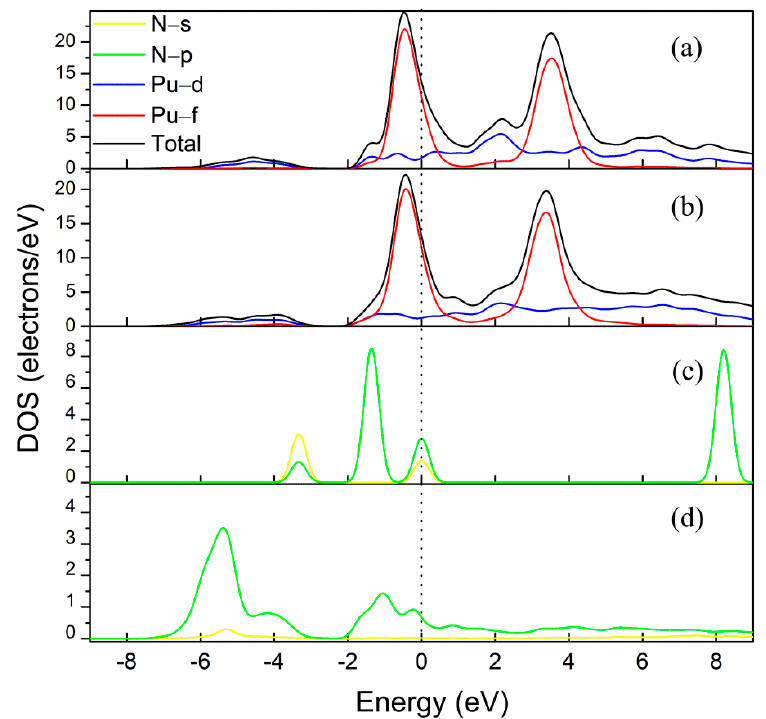
Figure 3. Partial density of states for ( a ) clean PuH 2 (111) surface; ( b ) PuH 2 (111) surface with adsorbed N 2 ; ( c ) gaseous N 2 , nitrogen; and ( d ) adsorbed N 2 . The smearing width was set to 0.2 eV and the Fermi levels were set at 0.